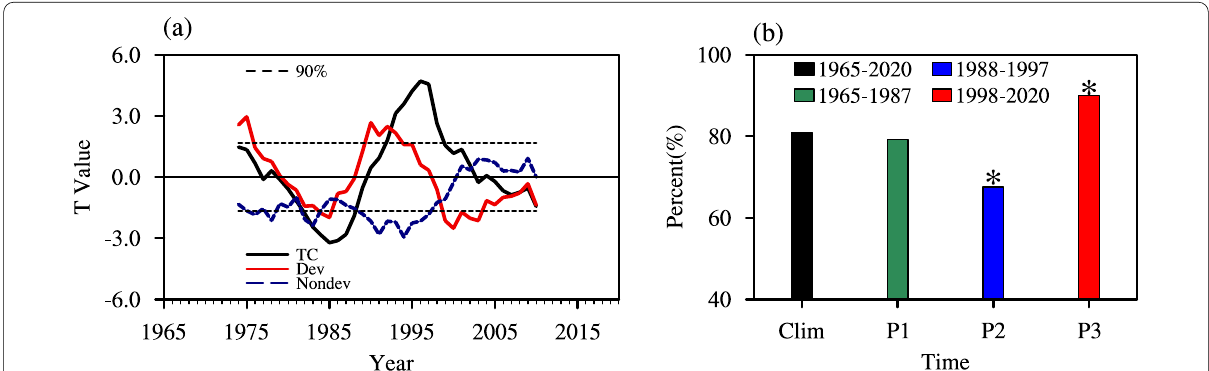
Fig. 6 a Running the Student’s t-test with a 10-year window for the numbers of TCs (solid black line), developing (solid red line), and nondeveloping (blue dotted line) disturbances over the WNP from 1965 to 2020. The black dashed lines indicate the lines of the 90% confidence level. b The percentage of developing disturbances to TCs from 1965 to 2020 (black), 1965 to 1987 (green), 1988 to 1997 (blue), and 1998 to 2020 (red). Black asterisks indicate the differences significant at the 95% confidence